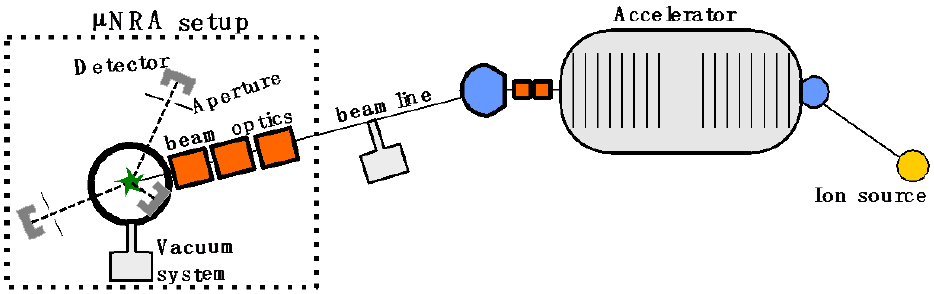
Figure 1. Sketch of the µNRA setup with the required modules and the target (green star) attached to a tandem accelerator. Blue objects depict dipole magnets. Orange squares depict ion beam focusing devices.